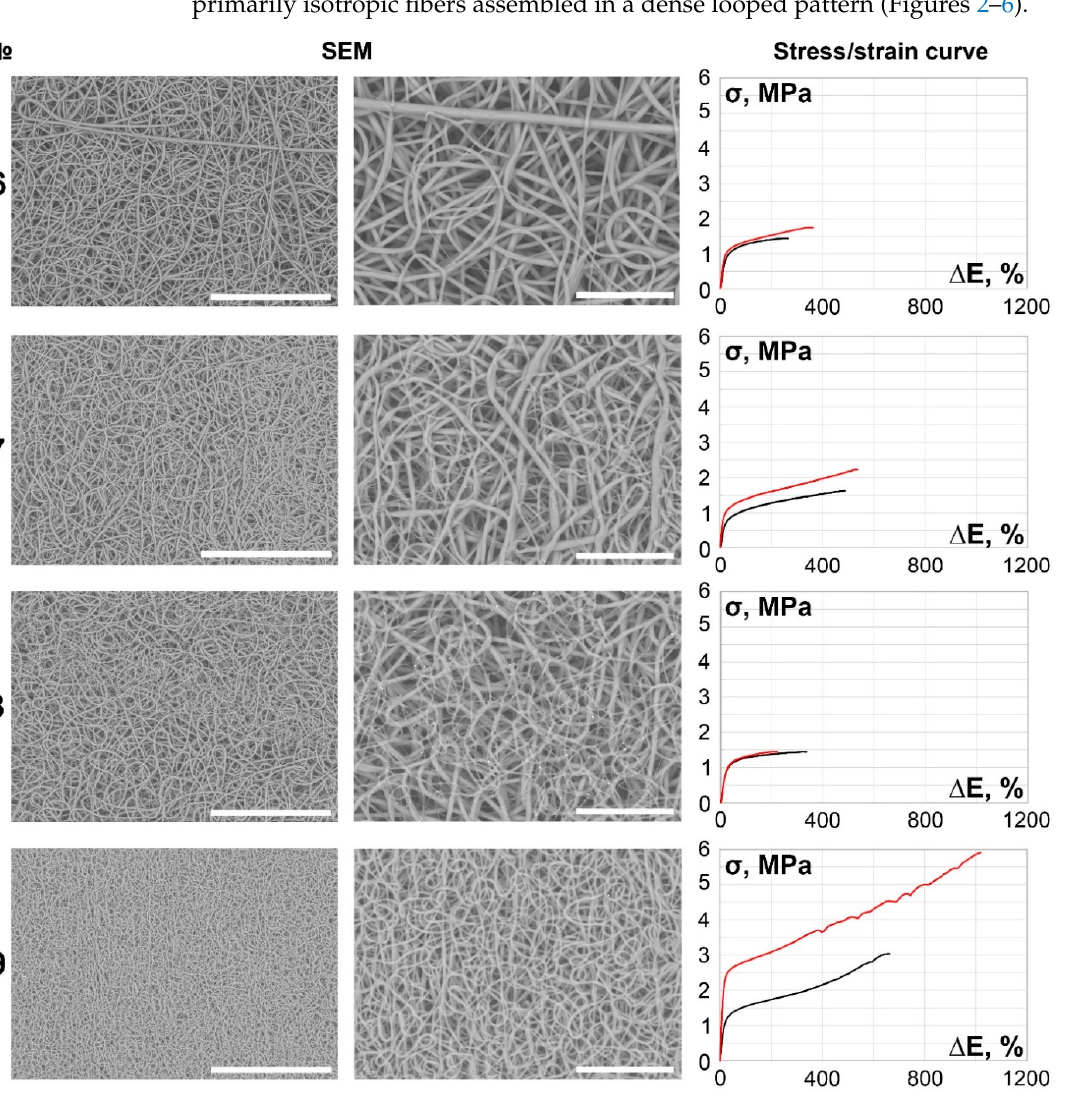
Figure 2. SEM images (×250 magnification, scale bar 200 µm and ×700 magnification, scale bar 50 µm) and stress/strain curves of tested 8% PCL samples. Red curves reflect stress/strain plotting in the axial direction; black curves correspond to circumferential stretching.